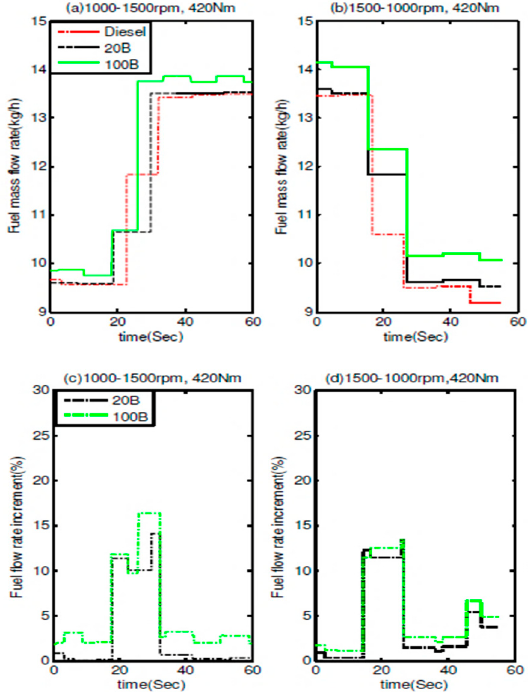
Figure 3. Time response during speed transients at 420 Nm of fuel flow rate for the CI with biodiesel with ( a ) positive and ( b ) negative speed transient. Fuel flow rate percentage increment with